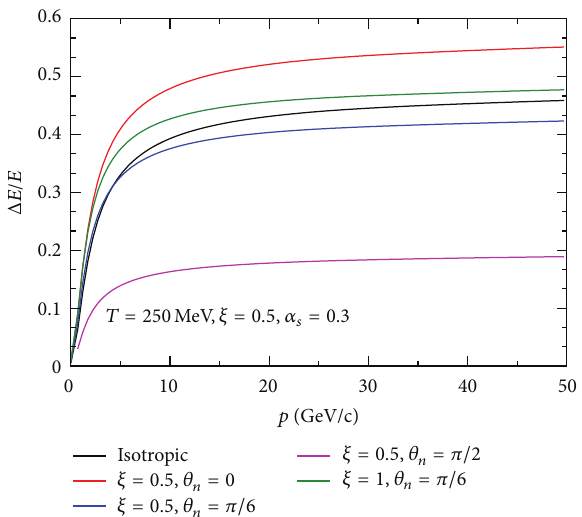
Figure 7: Color online: fractional energy loss for the light quark for 𝜉 = (0.5, 1)